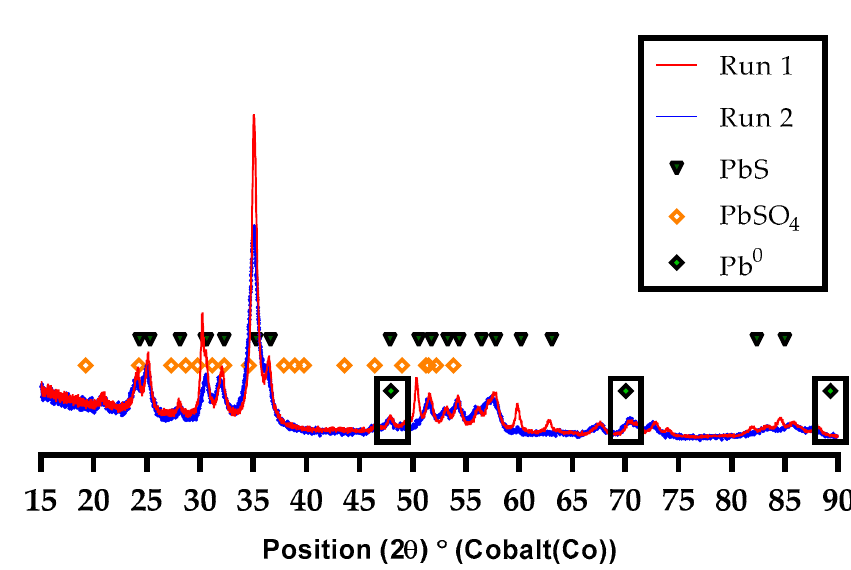
Figure 6. Comparison of the XRD profiles of precipitates harvested from runs 1 and 2.